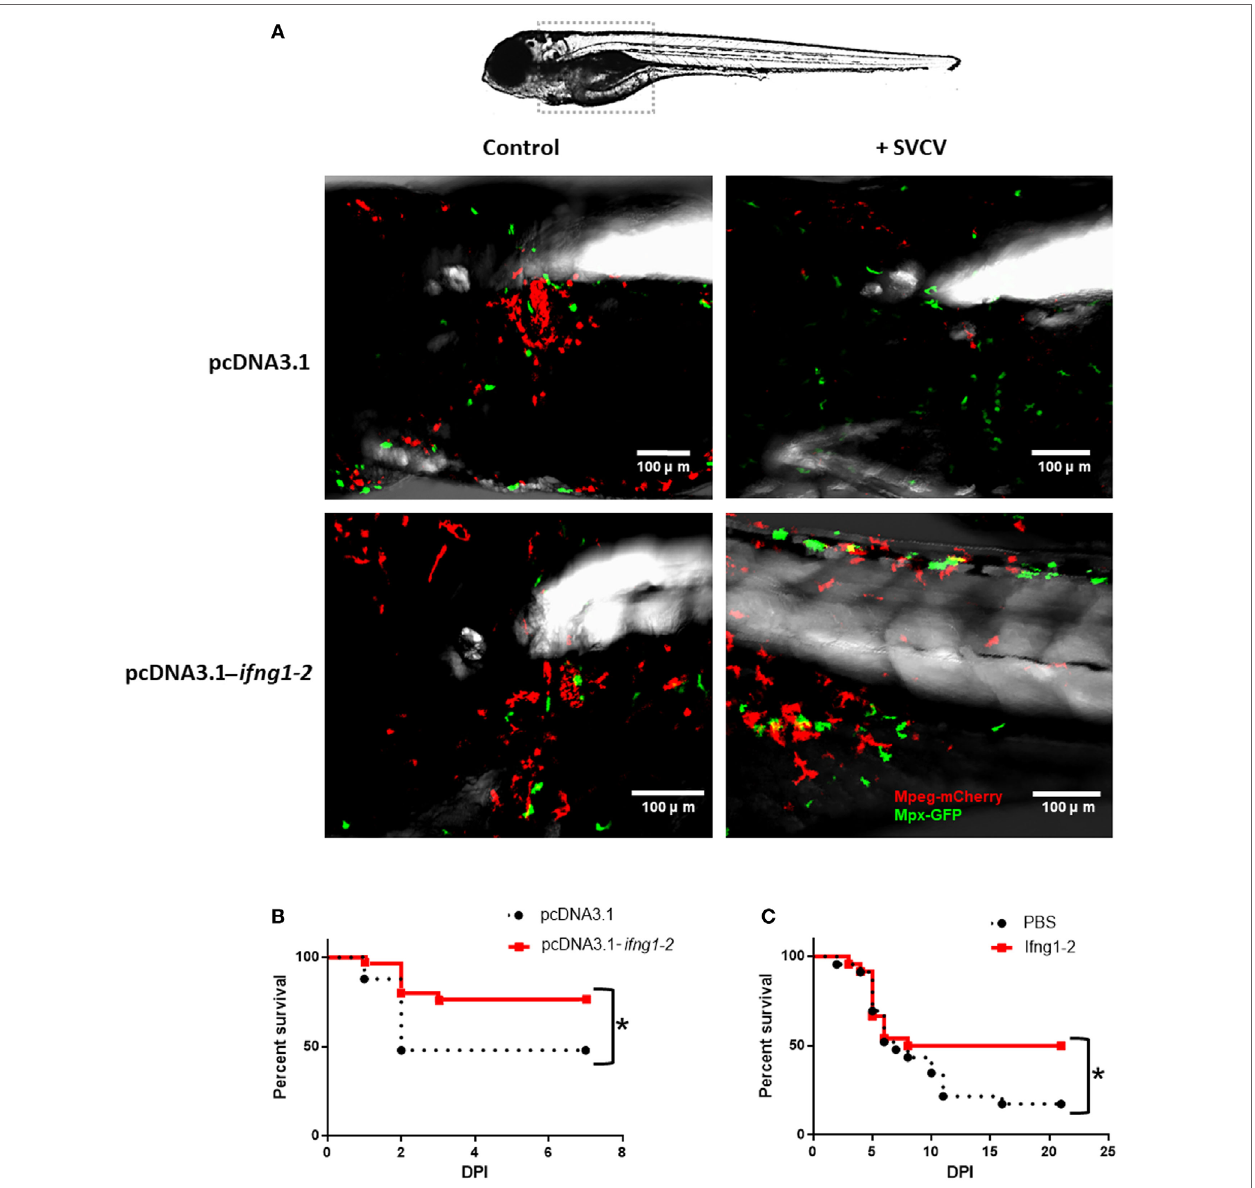
FigUre 6 | Effect of Ifng1-2 on the activation of immune cells and on survival against Spring Viremia Carp Virus (SVCV). (a) Zebrafish larvae overexpressing ifng1-2 show the activation of macrophages and neutrophils, with an evident change in morphology from a spherical morphology to a dendritic morphology. (B) Kaplan– Meier survival curves after SVCV challenge in zebrafish larvae overexpressing or not overexpressing ifng1-2 (c) Kaplan–Meier survival curves after SVCV challenge in adult zebrafish co-inoculated or not co-inoculated with the Ifng1-2 recombinant protein. Significant differences are represented by asterisks (* p <